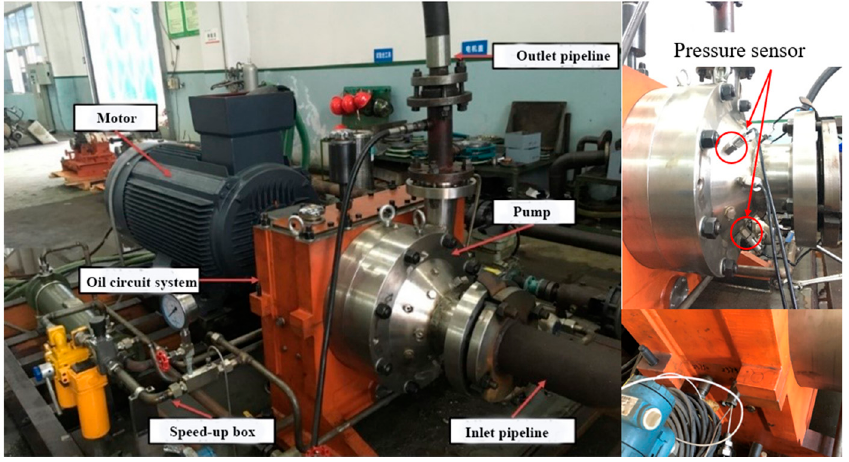
Figure 2. Figure of the pump. The data for the pressure fluctuations and the corresponding frequency under the rated operating condition of 130 m 3 /h are shown in Figure 3. The pressure ranges from